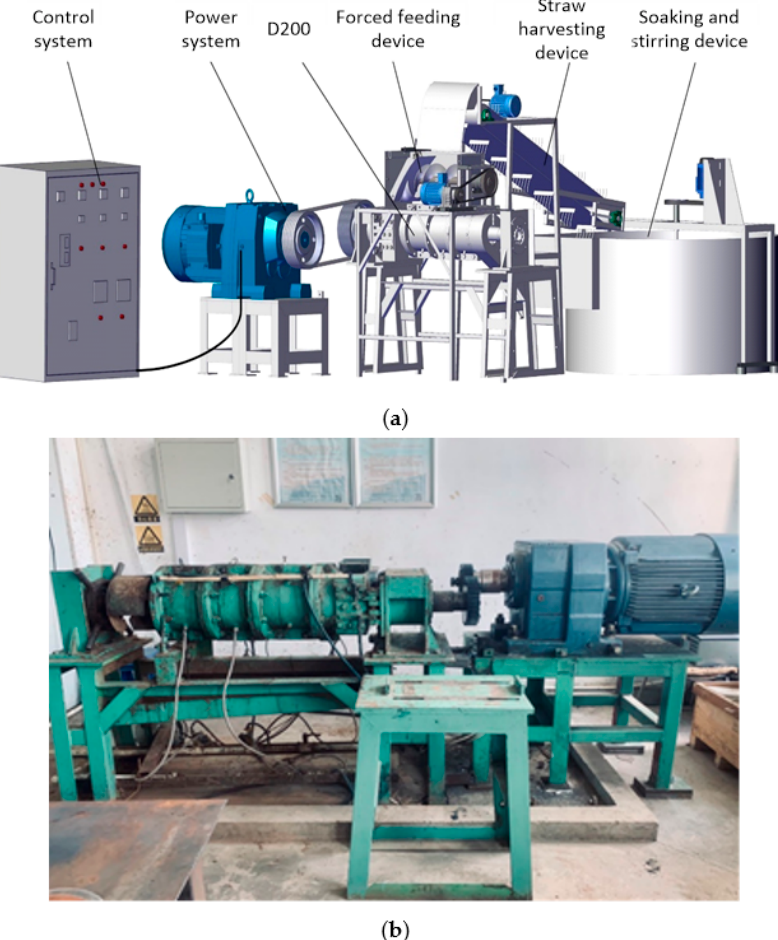
Figure 1. D200 single screw straw-based fiber extruder (( a ): schematic diagram; ( b ): physical draw- ing).